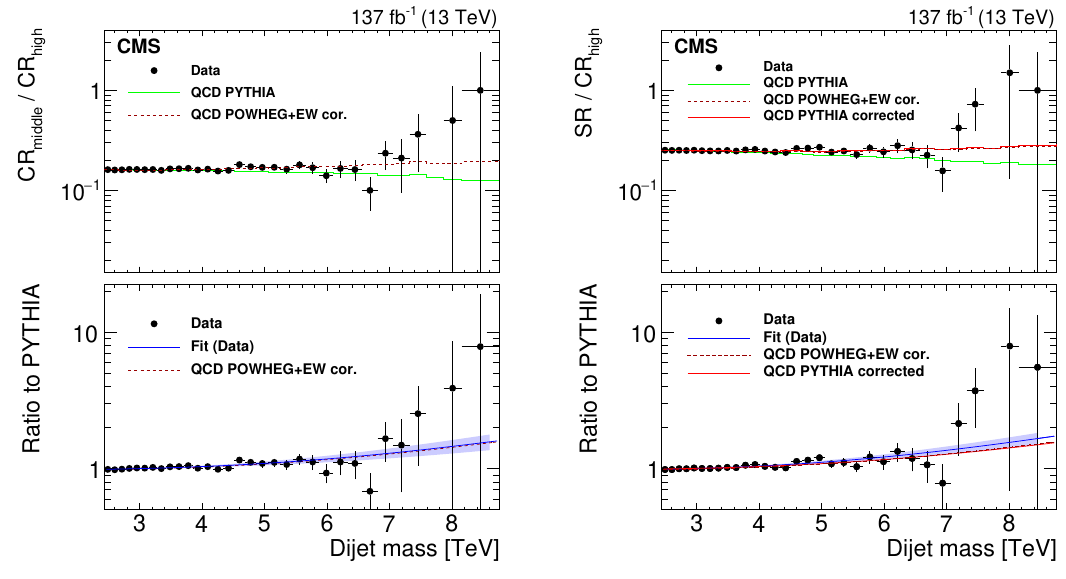
Figure 4 . The ratio R , the auxiliary transfer factor, calculated for data, pythia , and powheg aux with electroweak corrections (left, upper panel). The double ratio of the same quantities in the upper left panel to R from pythia , along with the (cid:12)t of the double ratio for data with the correction aux function (left, lower panel). The ratio R , the transfer factor, calculated for data, pythia , powheg with electroweak corrections, and corrected pythia (right, upper panel). The double ratio of the same quantities in the upper right panel to R from pythia , along with the (cid:12)t of the double ratio for data with a correction function, and corrected pythia using CR (right, lower panel). The (cid:12)ts middle in the two lower panels agree with each other within their uncertainty at 95% CL (shaded